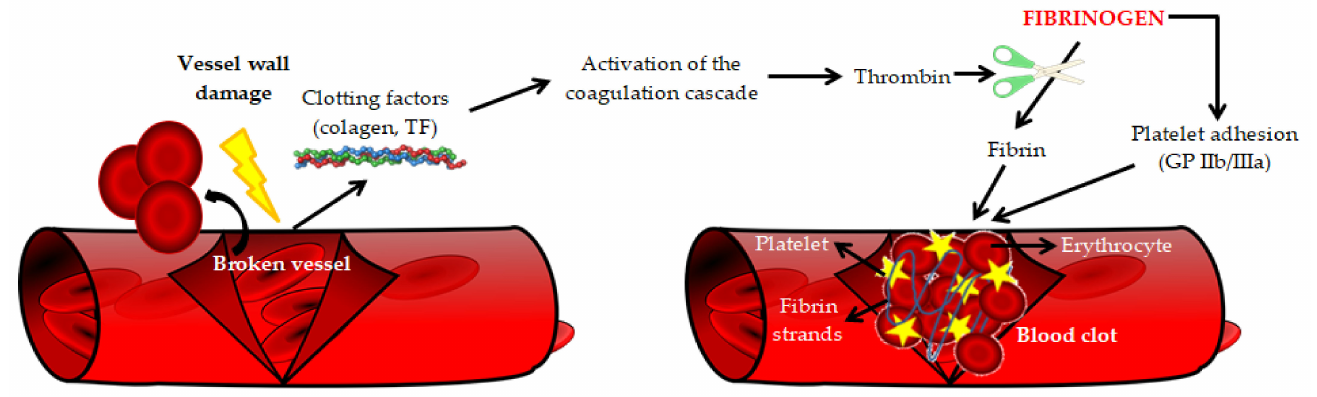
Figure 2. Theroleoffibrinogeninbloodcoagulation[21]. TF—Tissuefactor, GPIIb/IIIa—Integrinreceptors.